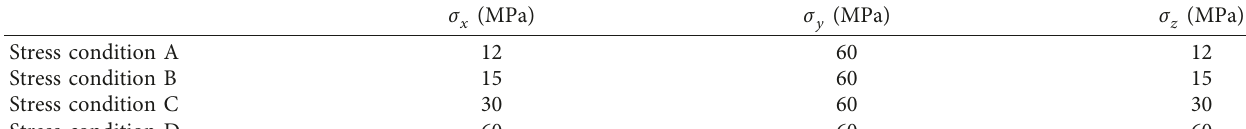
Table 3: Stress conditions applied to the numerical model.